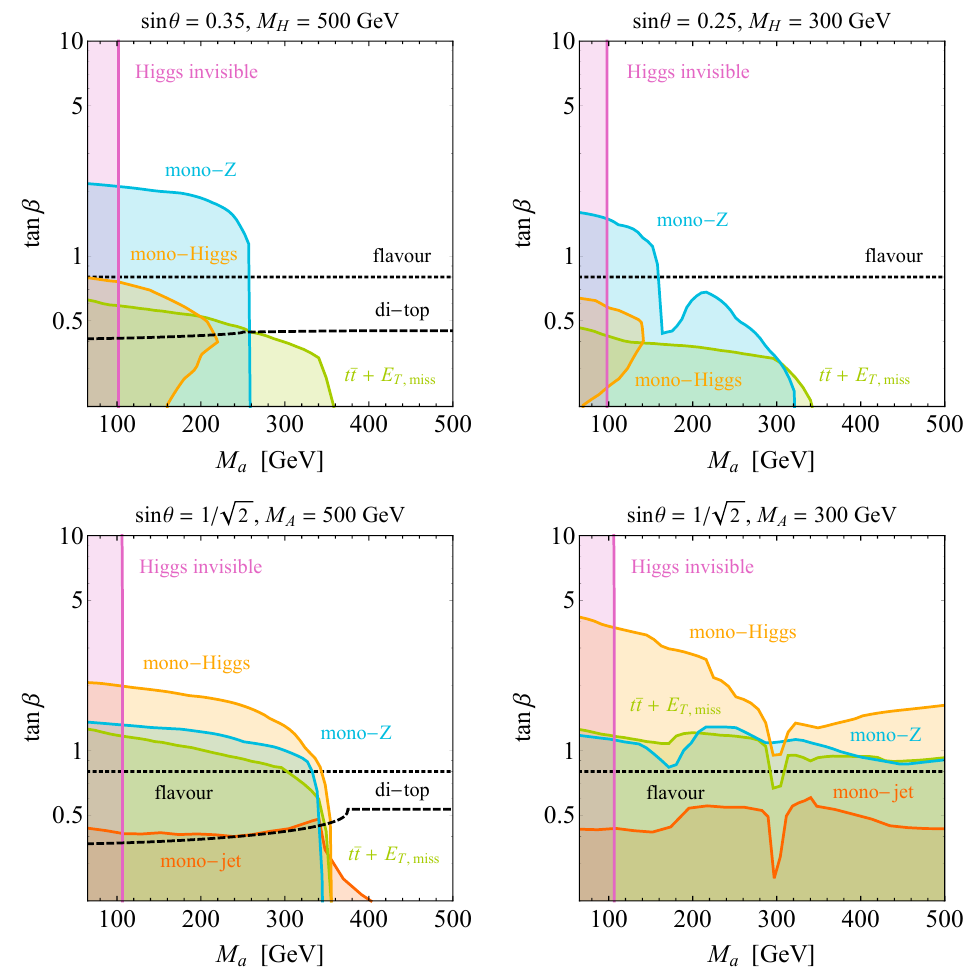
Figure 13 . Summary plots showing all relevant constraints in the M a {tan (cid:12) plane for four bench- mark scenarios. The colour shaded regions correspond to the parameter space excluded by the di(cid:11)erent E T; miss searches, while the constraints arising from di-top resonance searches and (cid:13)avour physics are indicated by the dashed and dotted black lines, respectively. Parameters choices below the black lines are excluded. All exclusions are 95% CL bounds. See text for further